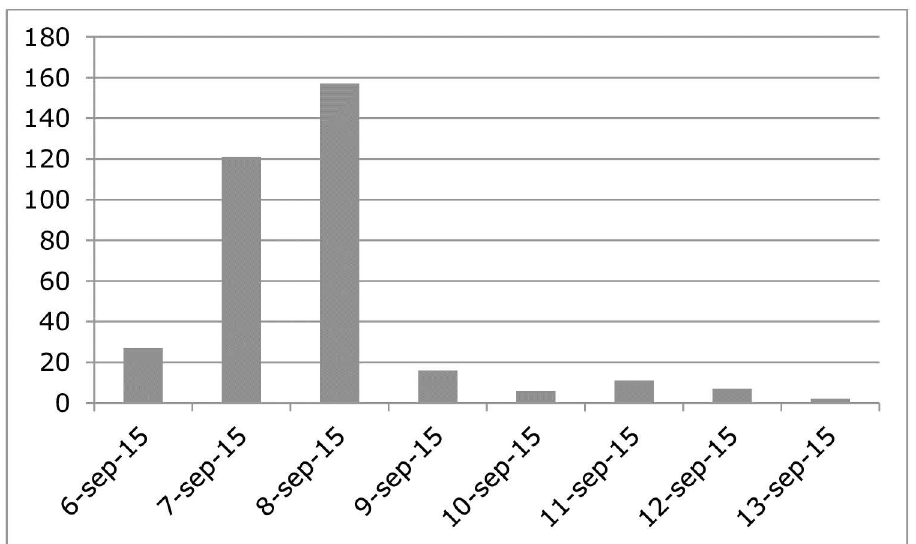
Fig 2. Epicurve Amsterdam City Swim, 6 September2015. The numberof cases by date of onset of AGI followingthe event.